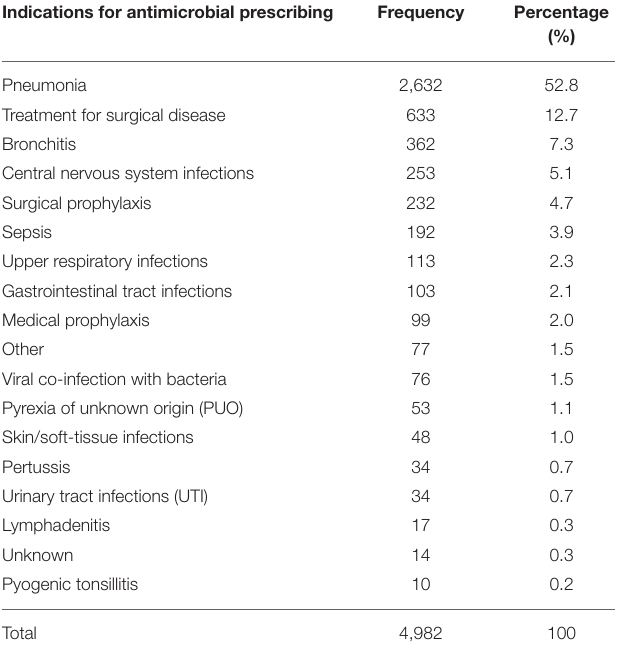
TABLE 2 | Indications of 4,982 antibiotic prescriptions for Chinese children. Indications for antimicrobial